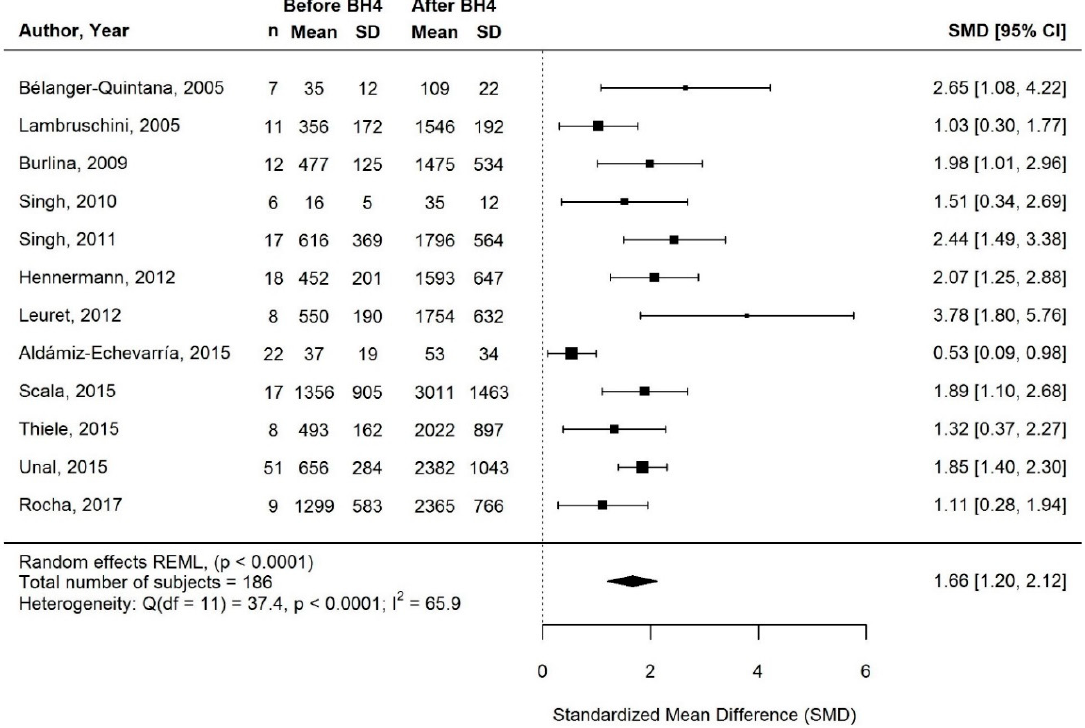
Figure 3. Standardized change in natural protein intake of long-term responders on BH4 treatment. Means and SDs before/after BH4 are gram natural protein per day for Demirdas (2013), and gram per kilogram bodyweight per day for all other studies. Abbreviations: BH4, tetrahydrobiopterin; CI: confidence interval; n: sample size; SD: standard deviation; SMD, standardized mean difference.